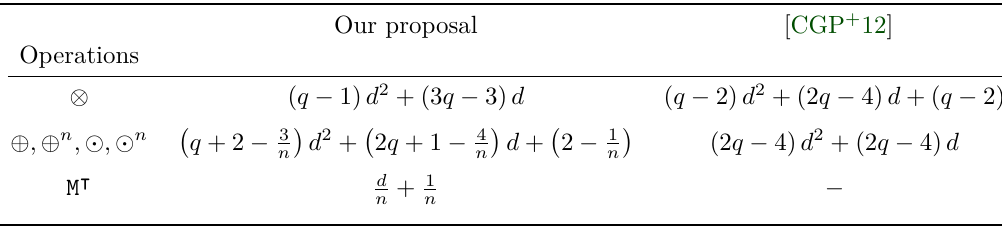
Table 1: Complexities of our proposal and the original method in terms of elementary operations.